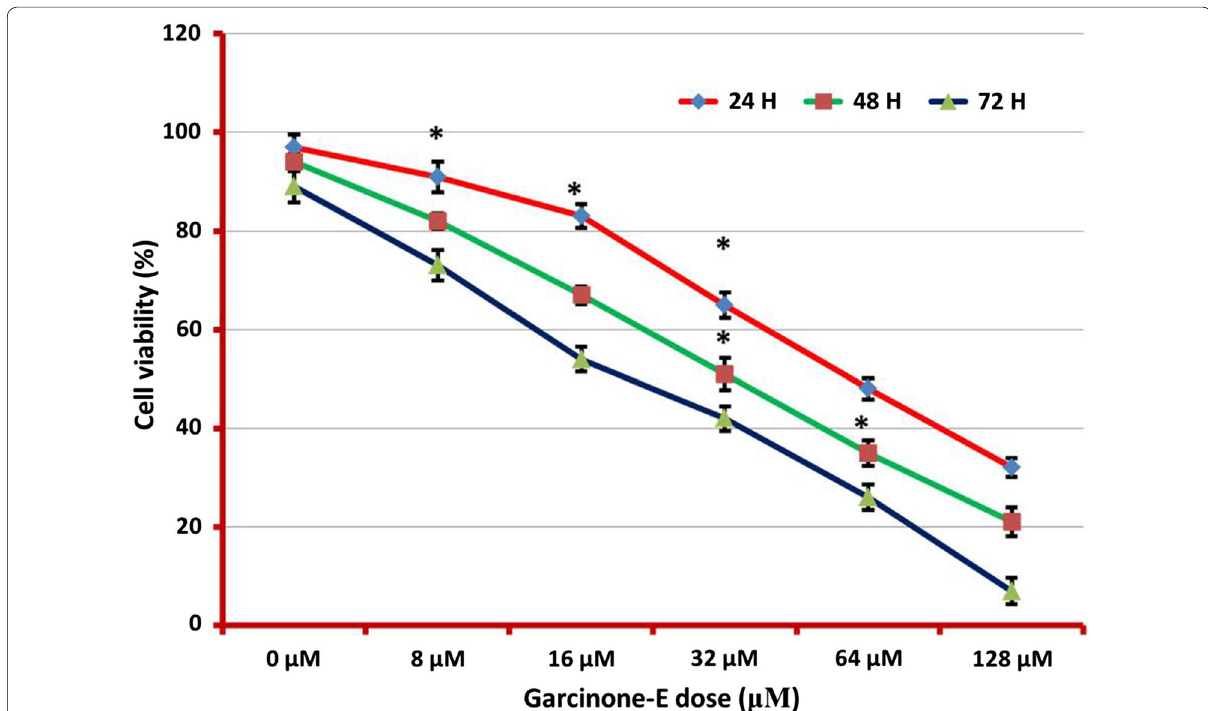
Fig. 2 MTT assay results indicating the rate of proliferation of cervical cancer HeLa cells and normal HCerEpiC human cervical epithelial cells. Both the cell lines were exposed to different concentrations (0–128 μM) of garcinone-E. Individual separate experiments were implemented three times considering p < 0.05 as statistically significant and data was signified as ±